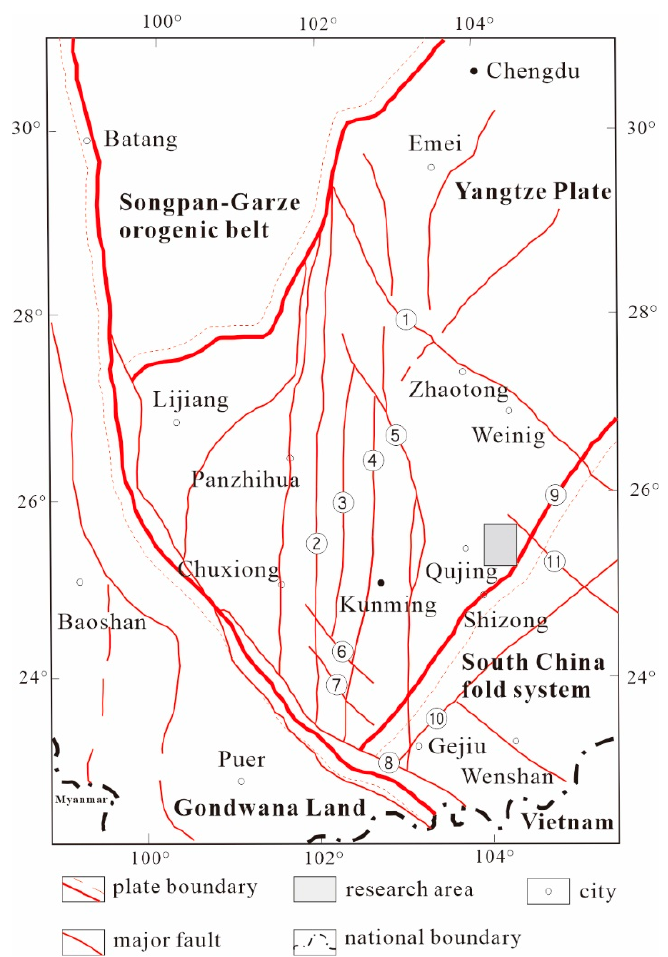
Figure 1. Tectonic location of the study area.1-Weining-Ziyun-Nandan fault, 2-Anninghe-Lvzhijiang fault, 3-Luoci-Yimen fault, 4-Puduhe-Dianchi fault, 5-Xiaojiang fault, 6-E’shan-Tonghai fault, 7-Huanian fault, 8-Red river fault, 9-Mi’le-Shizong fault, 10-Nanpanjiang fault, 11-Youjiang fault.